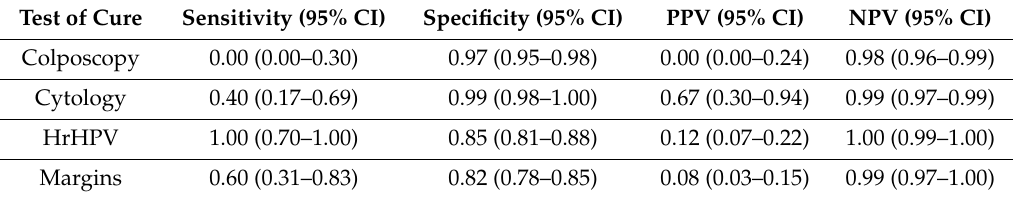
Table 3. Comparison of di ff erent tests of cure at 6 months and margin status at LLEZT to predict recurrence of HSIL lesions at 24-month follow-up. Recurrence of HSIL overall at 24 months was